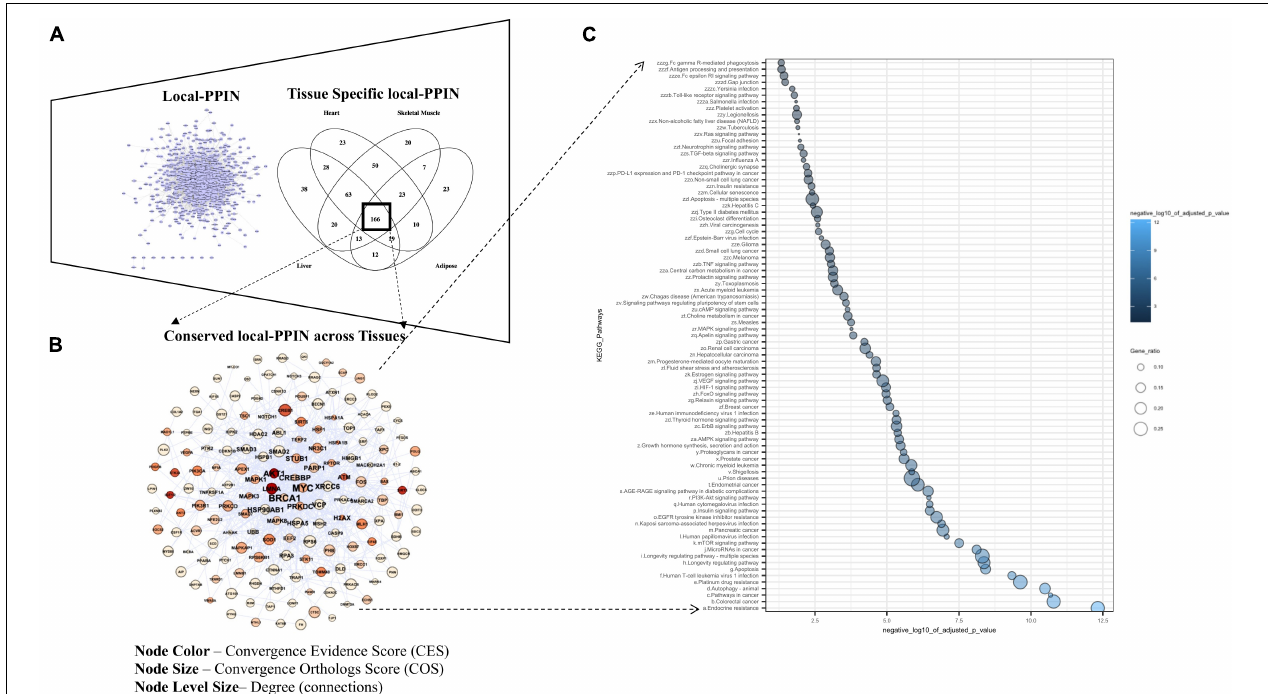
FIGURE 6 | Inter-tissue pathways associated with conserved module of local-PPIN. (A) Comparisons of tissue specific local-PPINs confirmed an overlapping of 166 aging and longevity related genes across four different human tissues (liver, heart, skeletal muscle, and adipose). (B) A total of 701 defined local-PPIs between 160 genes are conserved across all four studied local-PPIN. The node color and size represent the Convergent Evidence Score (CES) and Convergent Orthologs Score (COS) of genes respectively. The node level size indicates the connectivity statistics (degree value) of genes in the conserved local-PPIN across different human tissues. (C) The KEGG pathway enrichments for 160 genes in conserved local-PPIN across tissues highlighted 160 different pathways with P -value threshold < 0.05. The X -axis represents the negative log10 of the adjusted P -values (after Bonferroni correction) for each pathways term. The node size is corresponding to the Gene ratio which was calculated by subtracting the number of genes present in a particular pathway with the number of genes represent the respective pathway from our